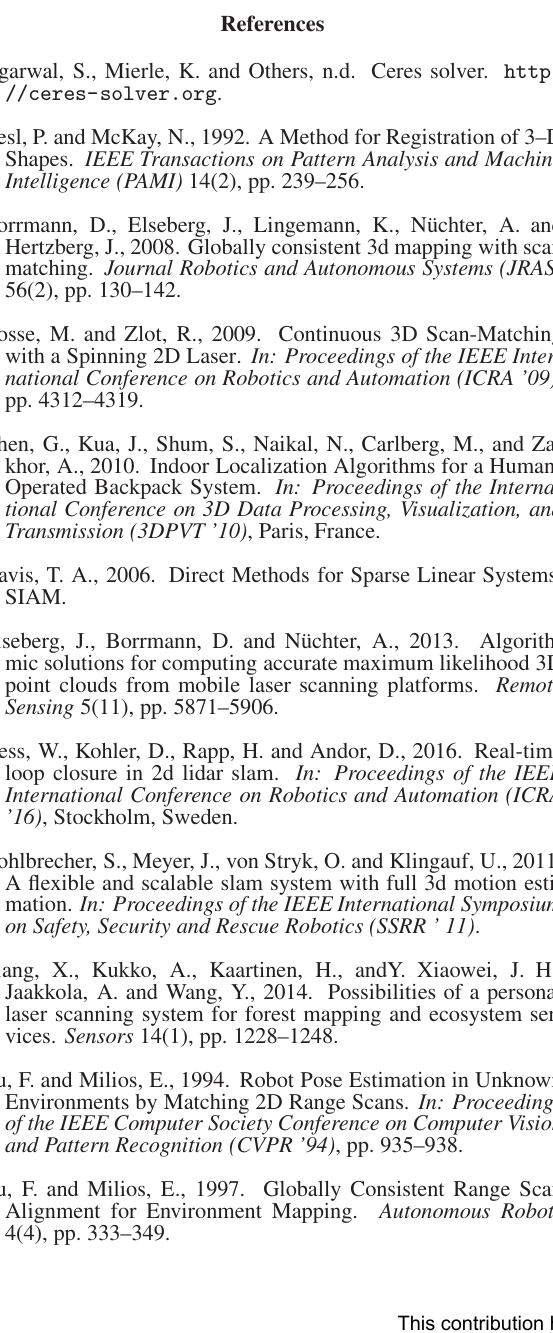
Figure 6: Visualization of the changes in the trajectory computed by our method to bootstraped trajectory. Left: distance. Right: